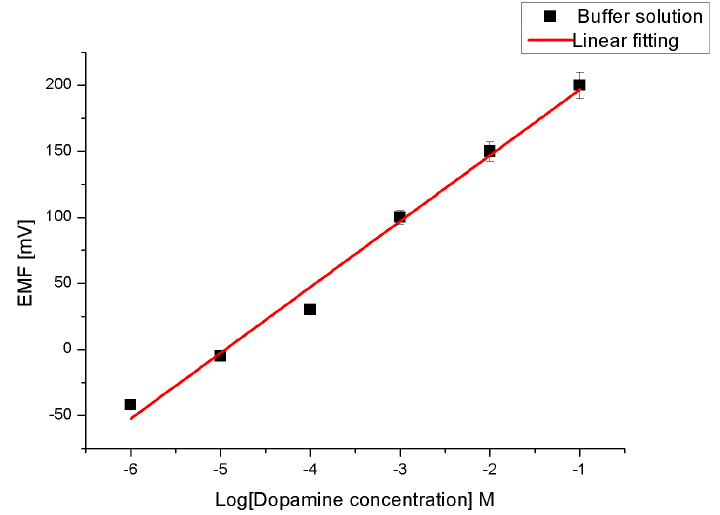
Figure 4. Calibration curve for the presented dopamine chemical sensor and the linear calibration equation is: y = 49.857 x + 246.6.